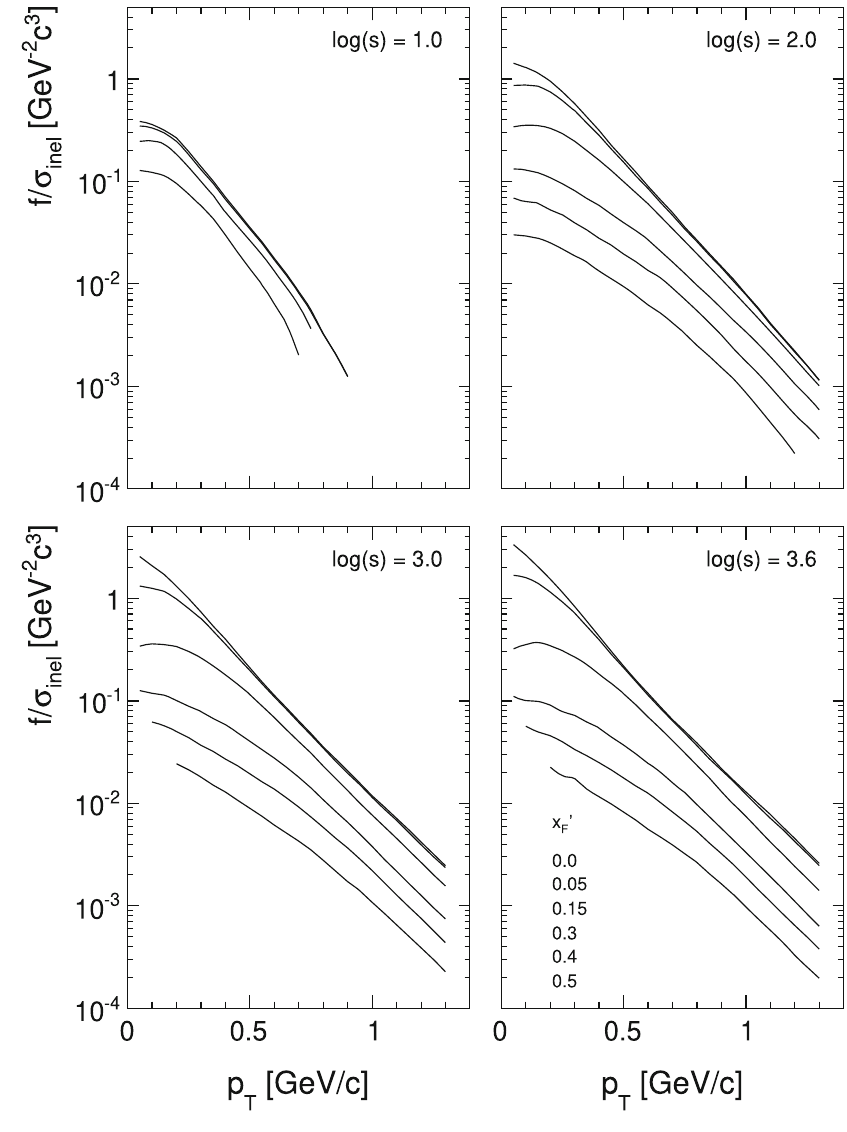
Fig. 135 Invariant π − cross section f /σ inel as a function of p T for several x (cid:3) and log ( s F